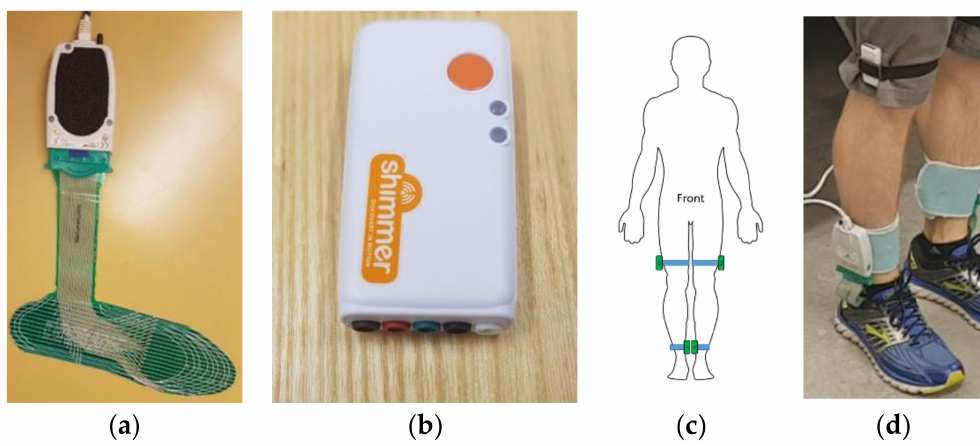
Figure 2. Sensor systems used in data collection: ( a ) FScan pressure-sensing insole, ( b ) Shimmer3 inertial measurement unit (IMU) sensor, ( c ) diagram of IMU placement, and ( d ) photograph of insole and IMU systems worn on